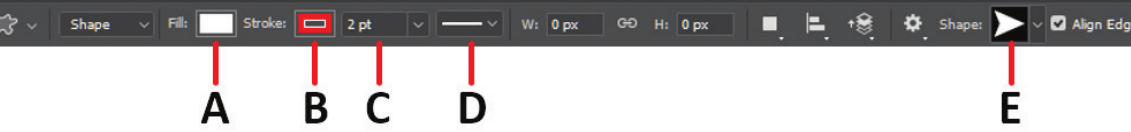
Figure 20. Shape tool properties bar. A . Sets the shape fill colour; B . Sets the stroke colour of the shape; C . Sets the stroke thickness; D . Sets the stroke type; E . If it is a custom shape, it defines which shape is chosen.